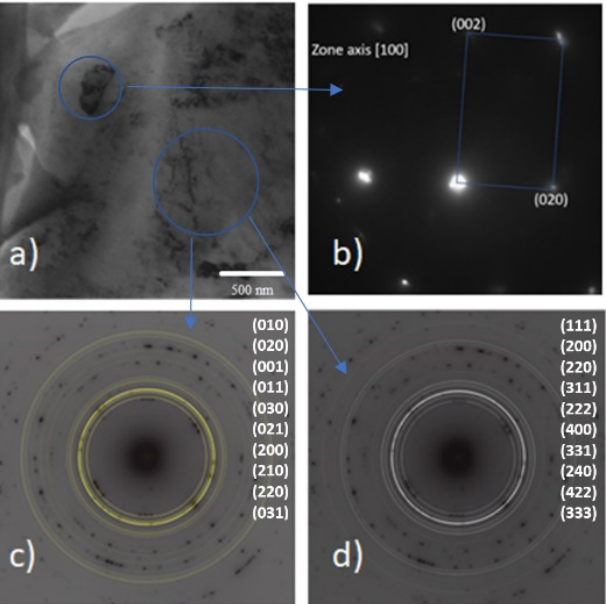
Figure 15. ( a ) TEM image (bright field) and diffraction patterns of characteristic precipitates in 8620 steel deformed and quenched at 1100 °C. ( b ) Diffraction pattern of Fe 3 C, ( c ) diffraction rings compatible with M 7 C 3 and ( d ) diffraction rings compatible with M 23 C 6 .